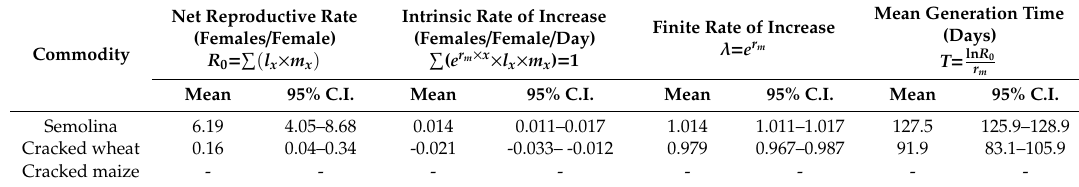
Table 3. Values of net reproductive rate ( R 0 ), intrinsic rate of increase ( r m ), finite rate of increase ( λ ) and mean generation time ( T ) of Tribolium castaneum (mean, 95% C.I.) fed on three commodities. Where dashes exist no demographic parameters were